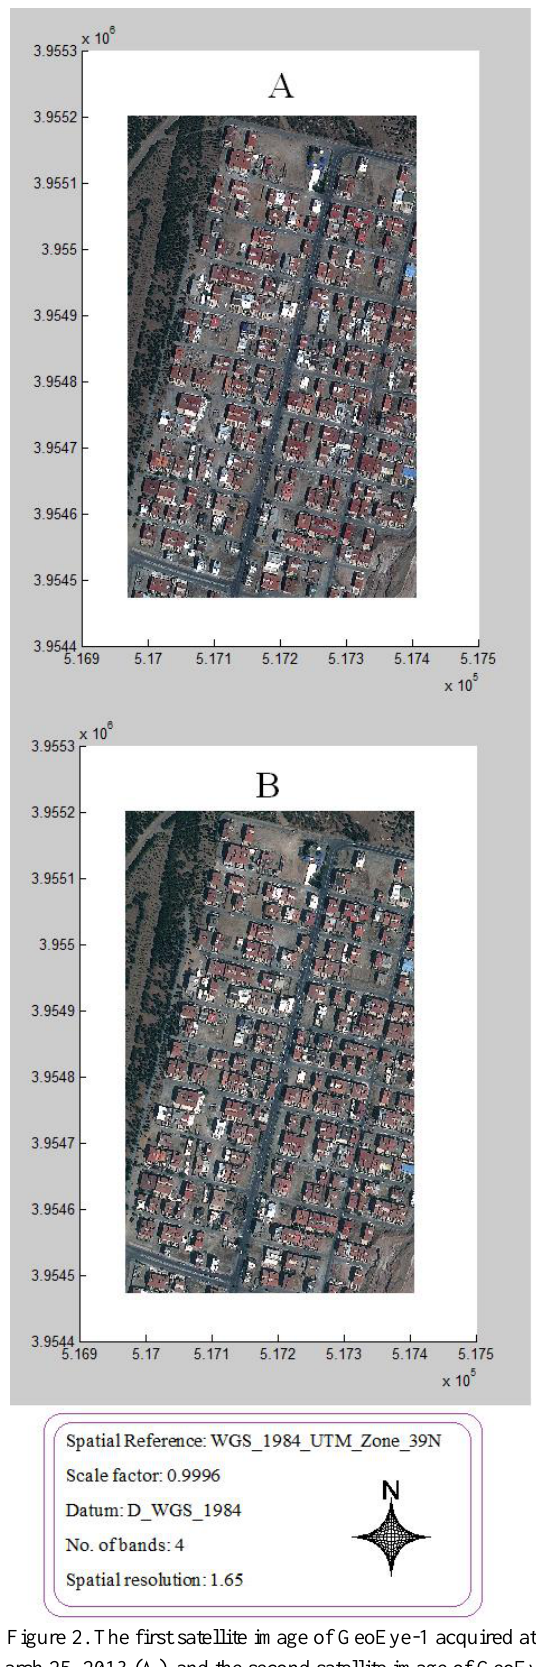
Figure 2. The first satellite image of GeoEye-1 acquired at March 25, 2013 (A), and the second satellite image of GeoEye- 1 acquired at October 16, 2013